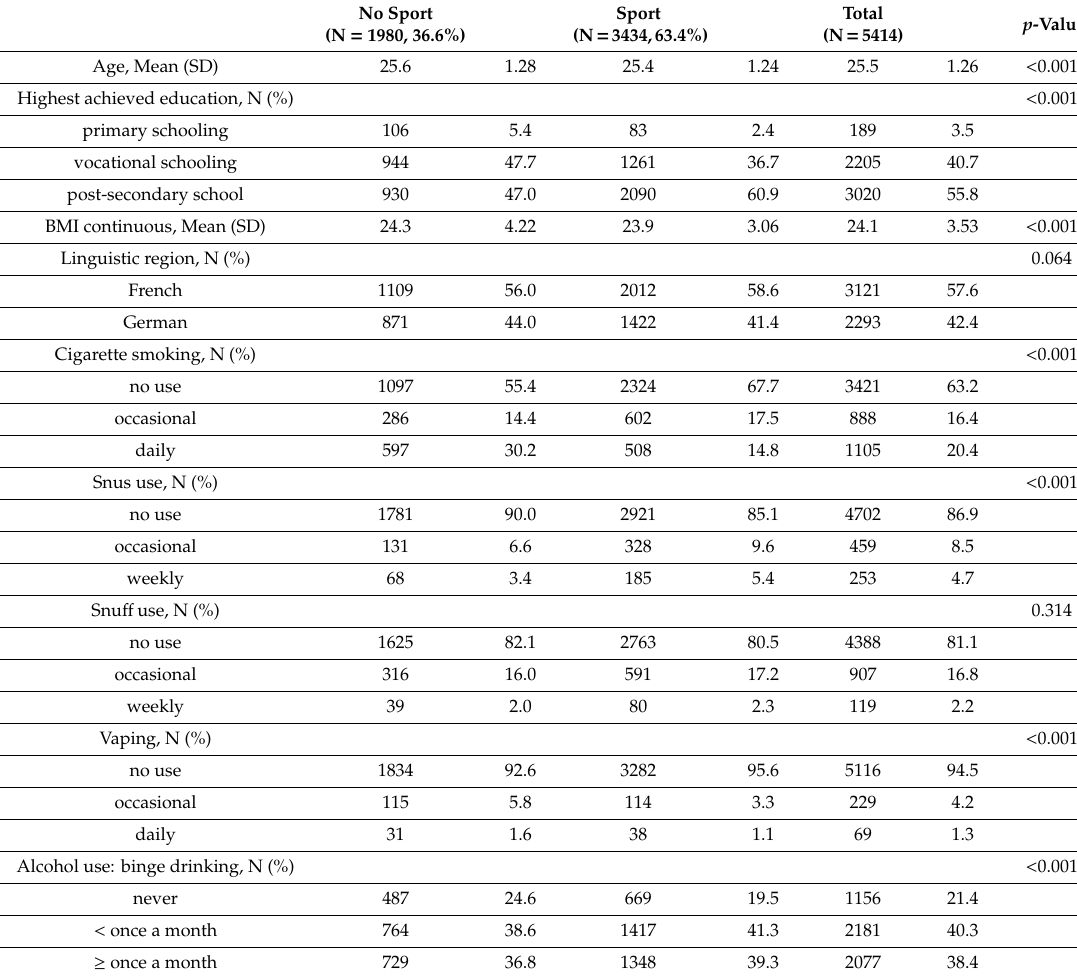
Table 1. Sample characteristics of participants (N =